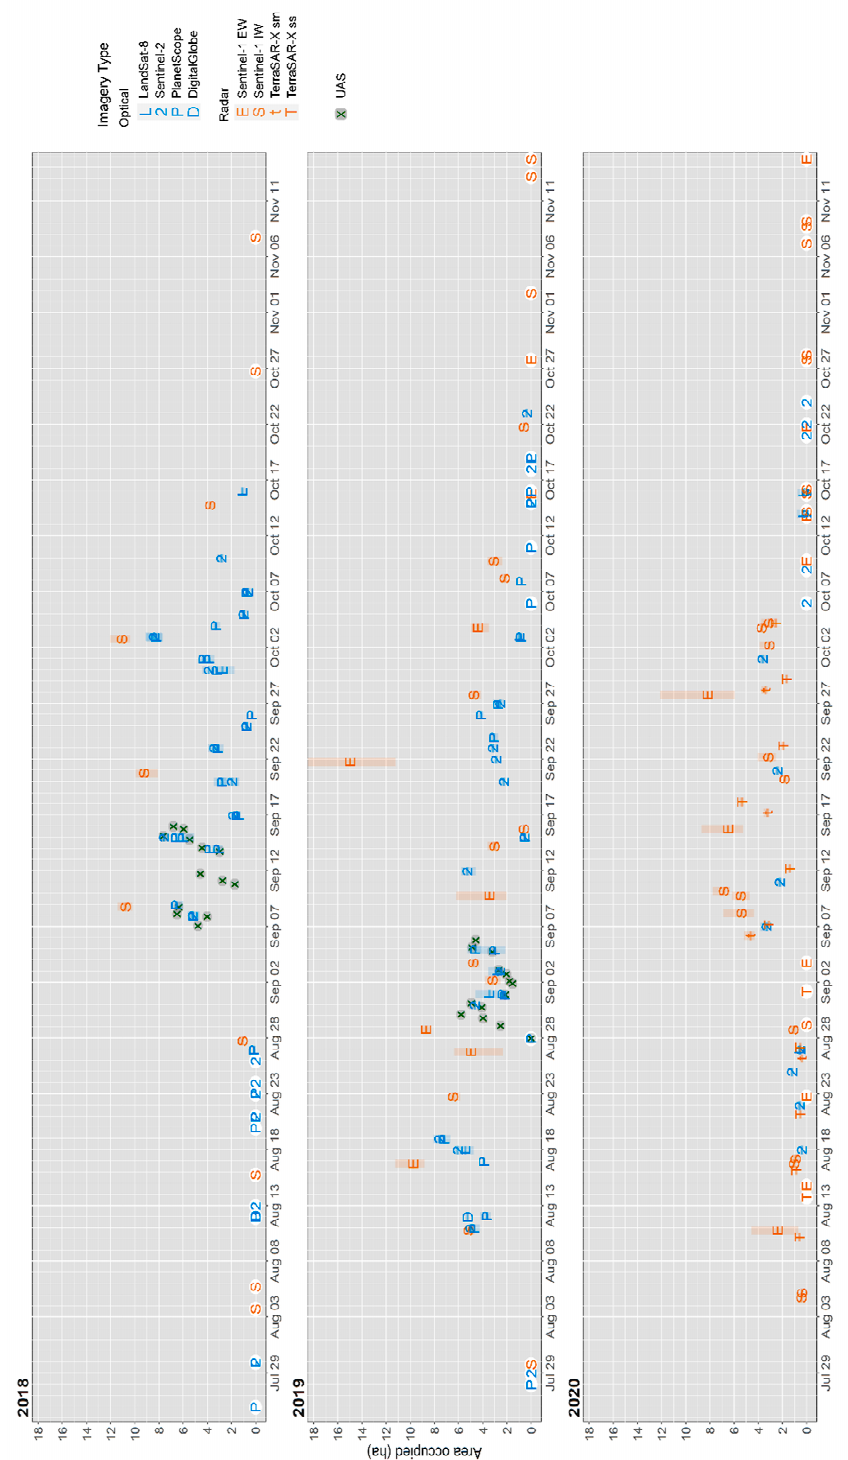
Figure 2. Size of the area occupied by walrus aggregations hauled out at Point Lay Alaska during 25 July–15 November 2018, 2019, and 2020 interpreted from various imagery types. Colored symbols indicate the mean estimated area among the three observers and shaded vertical bars indicate the full range of estimates. Symbol color denotes optical (blue) or SAR (red) imagery. The size of areas interpreted from UAS surveys are displayed as gray dots with an embedded “X”. Images interpreted to have no walruses present are plotted with a white circular background to distinguish them from images with a small area of